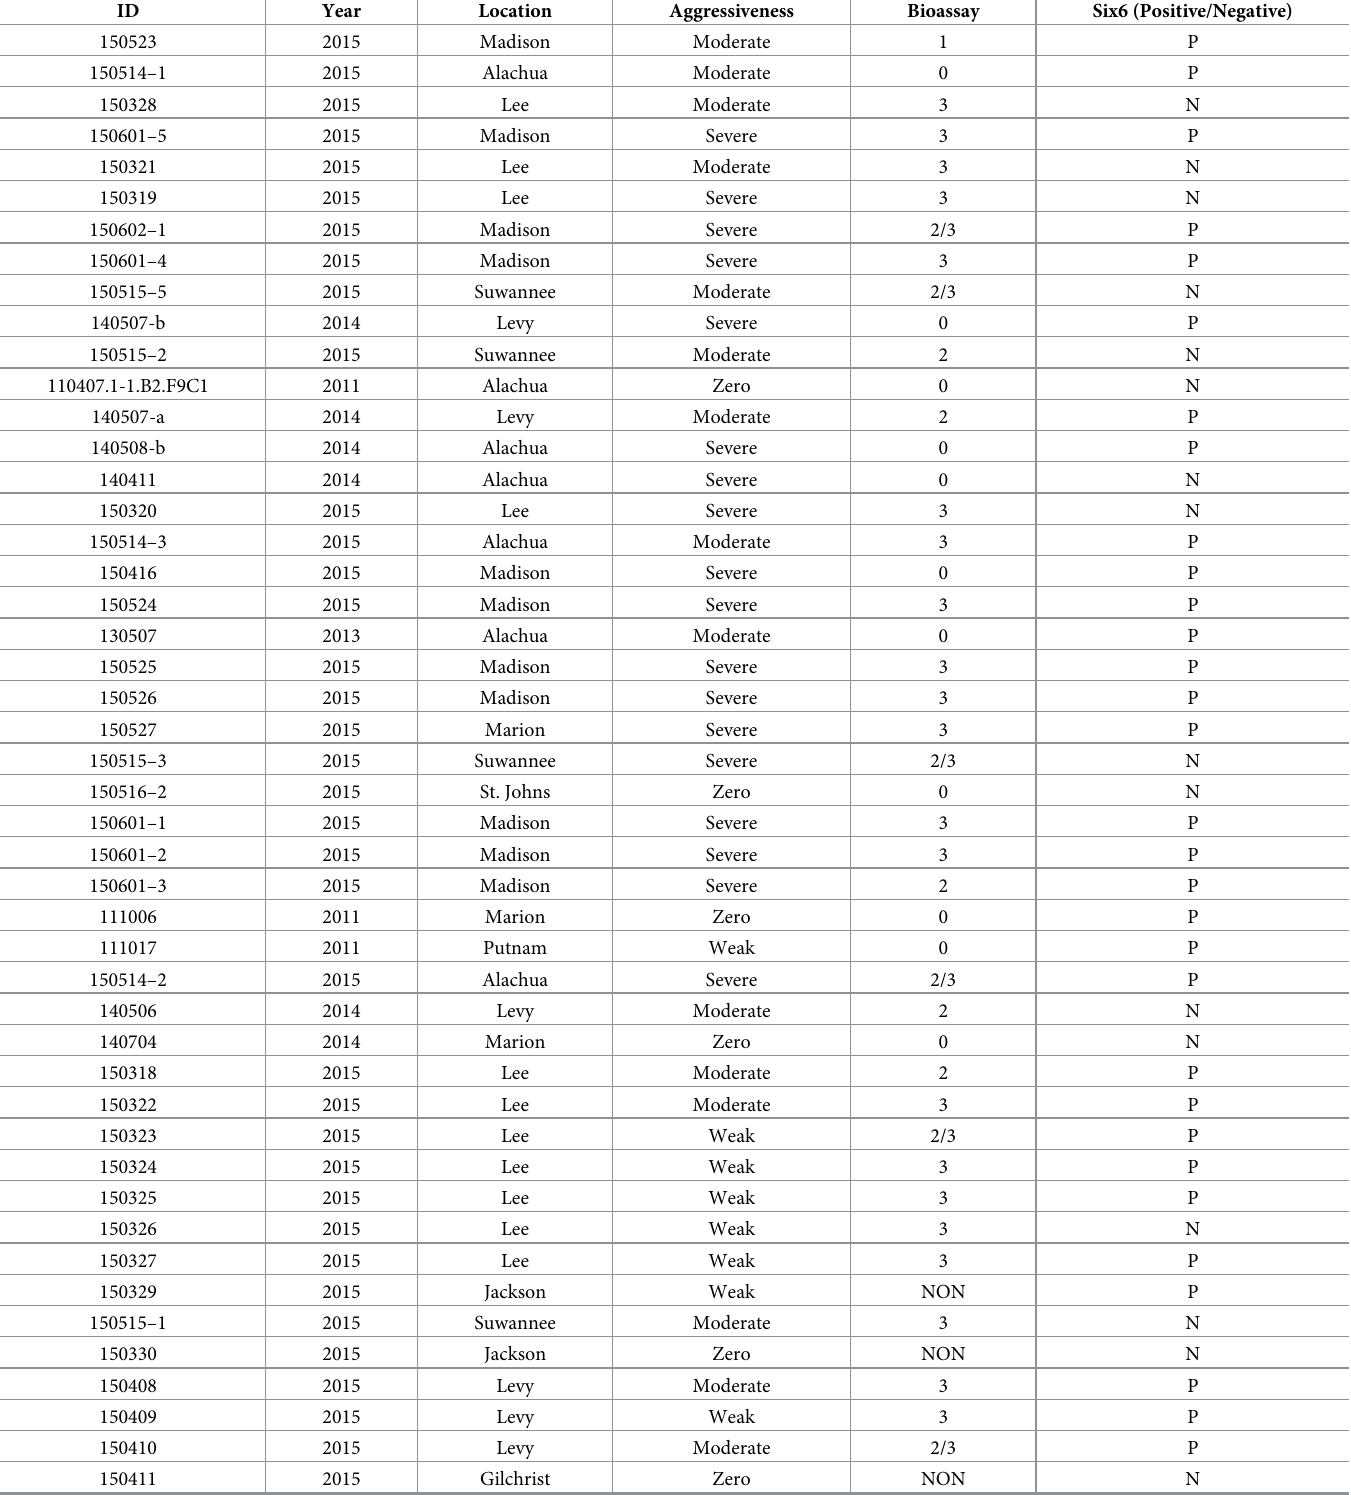
Table 1. Fusarium oxysporum f. sp. niveum [4] isolates analyzed in this study. Fon host plant was watermelon unless otherwise